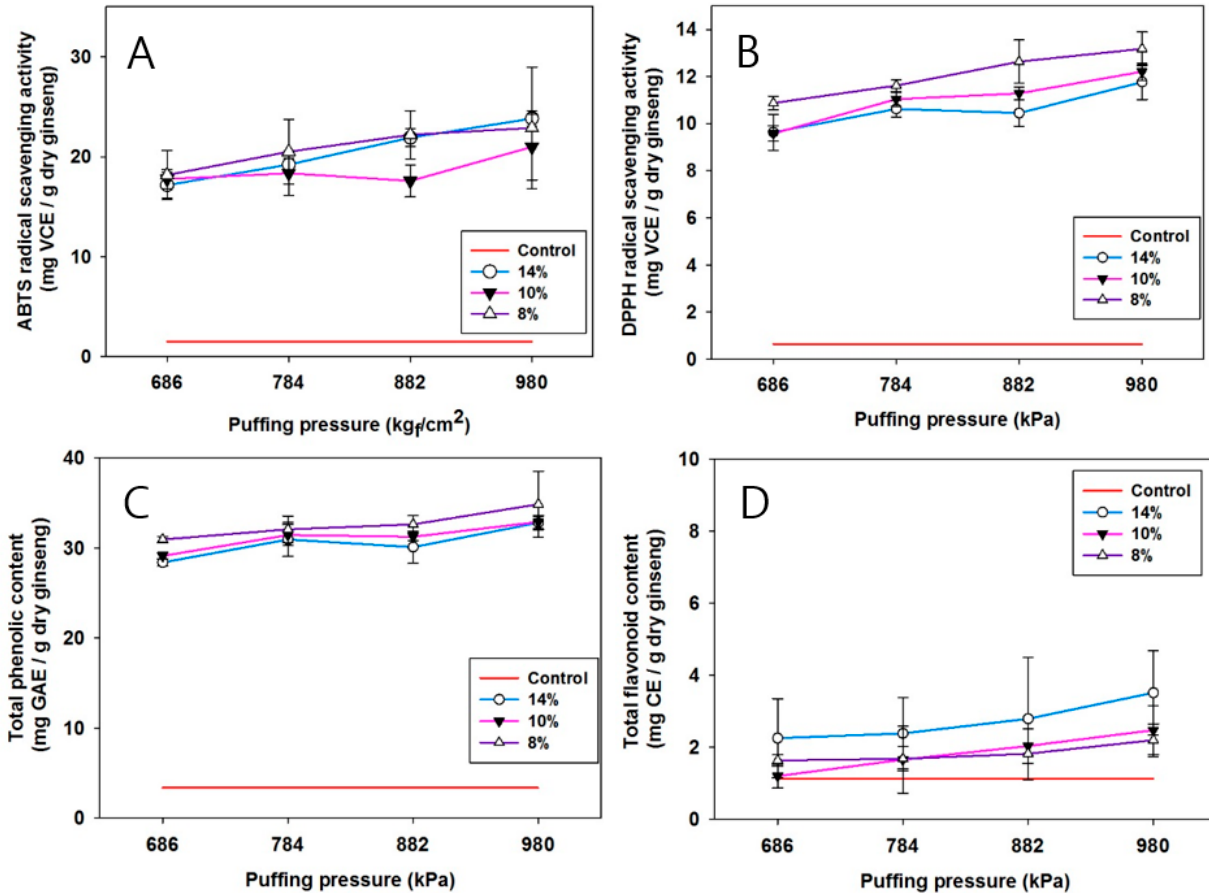
Figure 3. Effects of puffing pressure and water content on ABTS radical scavenging activity ( A ), DPPH radical scavenging activity ( B ), total phenolic content ( C ), and total flavonoid content ( D ) of puffed CWPG.